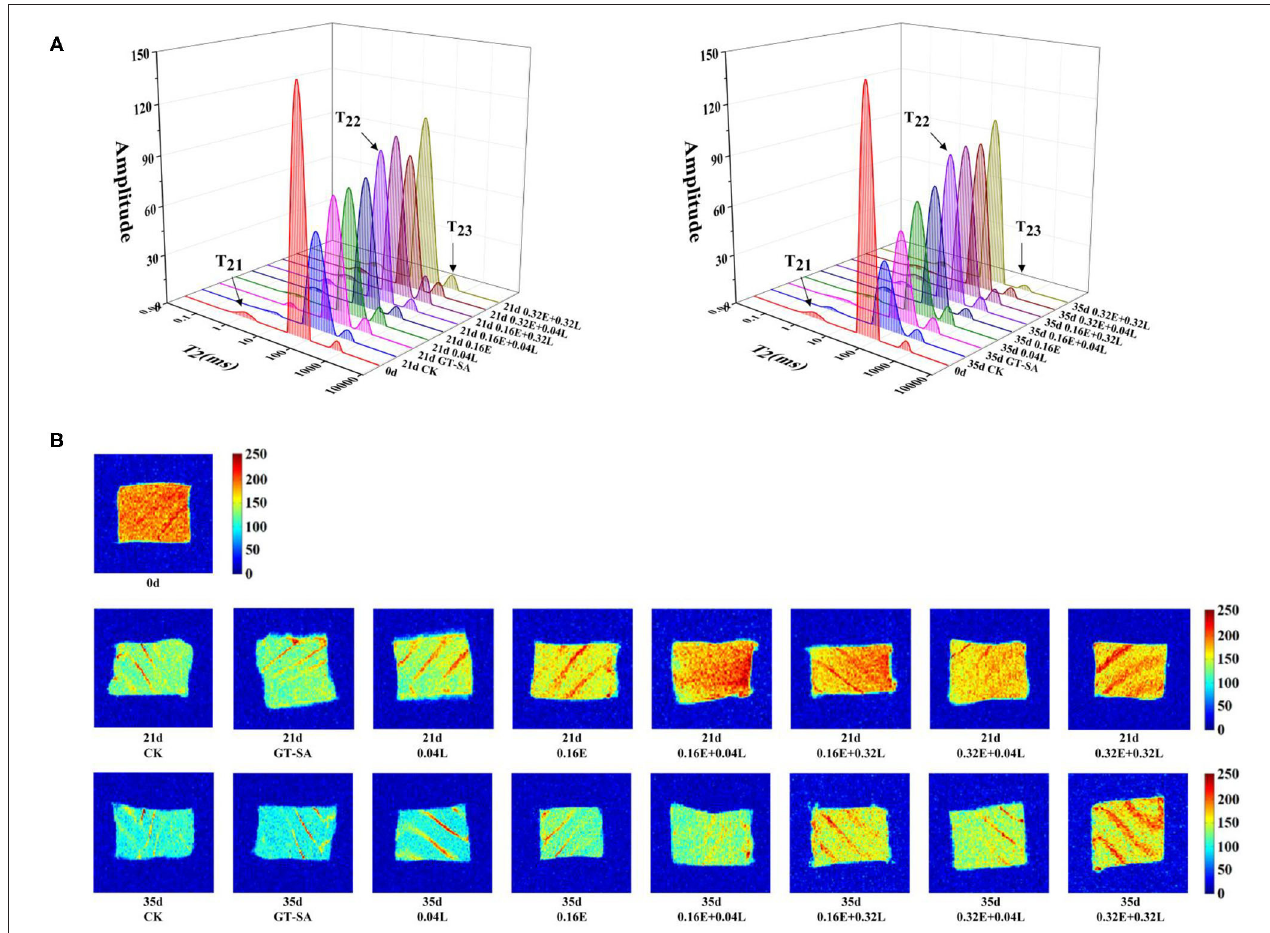
FIGURE 1 | Changes in water distribution (A) and magnetic resonance imaging (B) of large yellow croaker samples during superchilling storage (CK, uncoated; GT-SA, GT-SA coating without preservatives; 0.04L, GT-SA coating with 0.04 mg · ml − 1 LYS; 0.16E, GT-SA coating with 0.16 mg · ml − 1 EGCG; 0.16E + 0.04L,